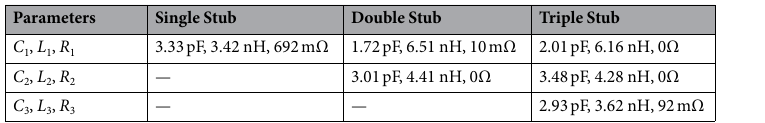
Parameters Single Stub Double Stub Triple Stub